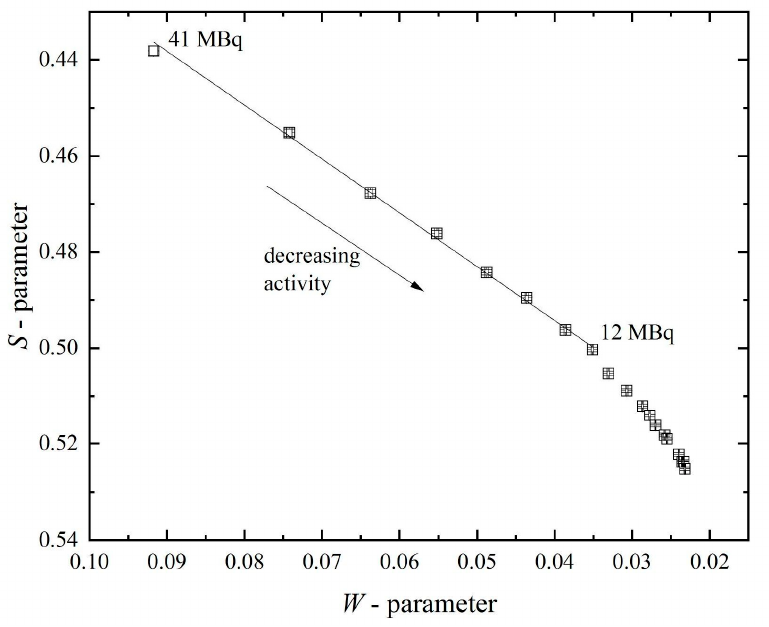
Figure 8. Dependence of S - on W -parameter for spectra with the different activity of positron source.